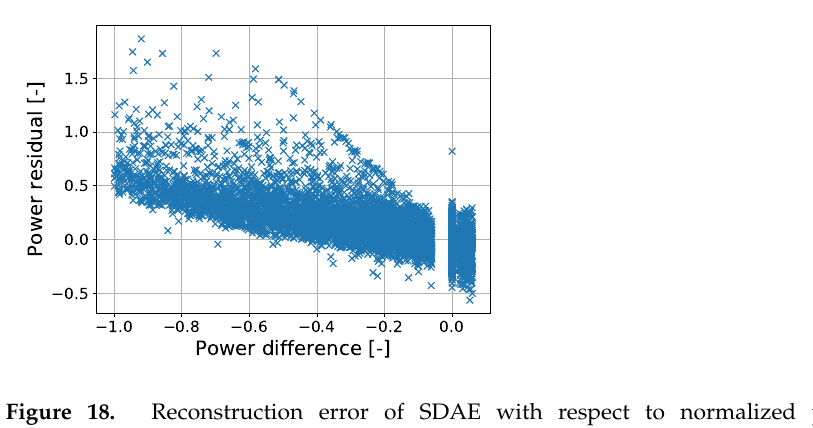
Figure 17. Reconstruction error of SDAE on normal operating data (blue) and artificially introduced anomalies (orange).